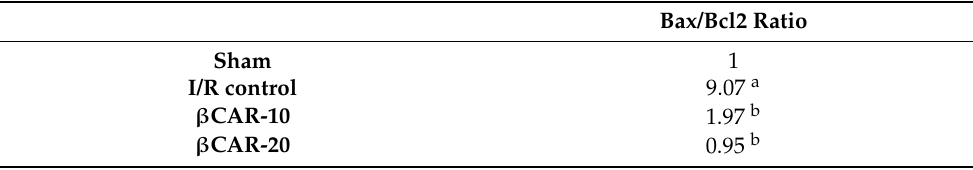
Figure 9. Effects of β CAR on Bax ( A ) and Bcl-2 ( B ) mRNA expression in ischemic cerebral tissues of rats. Values are presented as fold changes of sham control value ± SEM ( n = 6) after normalization by β -actin. a, b denotes significant difference at p ≤ 0.05 against sham and I/R control groups, respectively. Table 2. Bax/Bcl2 mRNA ratio in ischemic cerebral tissues of rats.